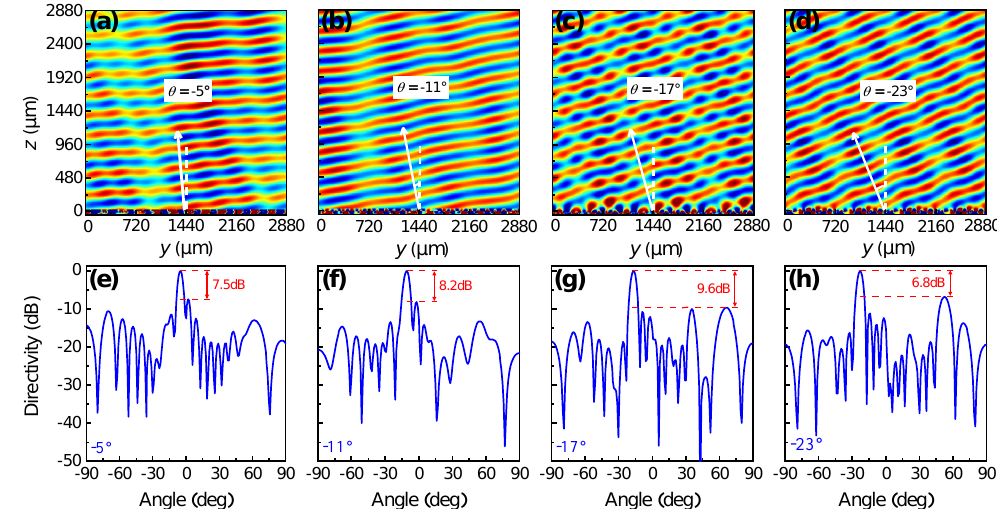
Figure 6. ( a – d ) Near-field electric field distributions | E x | and ( e – h ) far-field directivity for deflected reflection angles of ( a , e ) θ = − 5 ◦ ; ( b , f ) − 11 ◦ ; ( c , g ) − 17 ◦ ; and ( d , h ) − 23 ◦